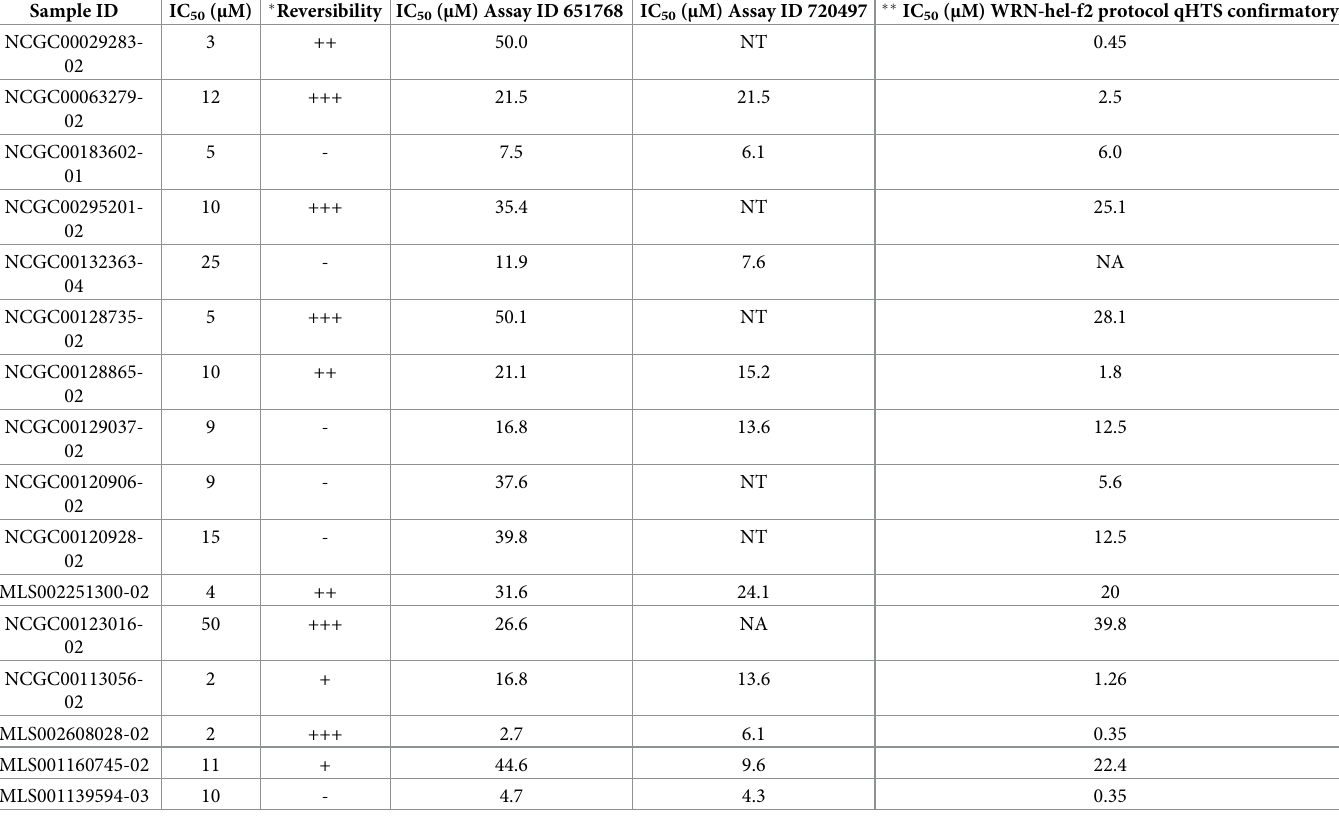
Table 2. Summary of IC 50 ( μ M) and reversibility results for selected compounds. Sample